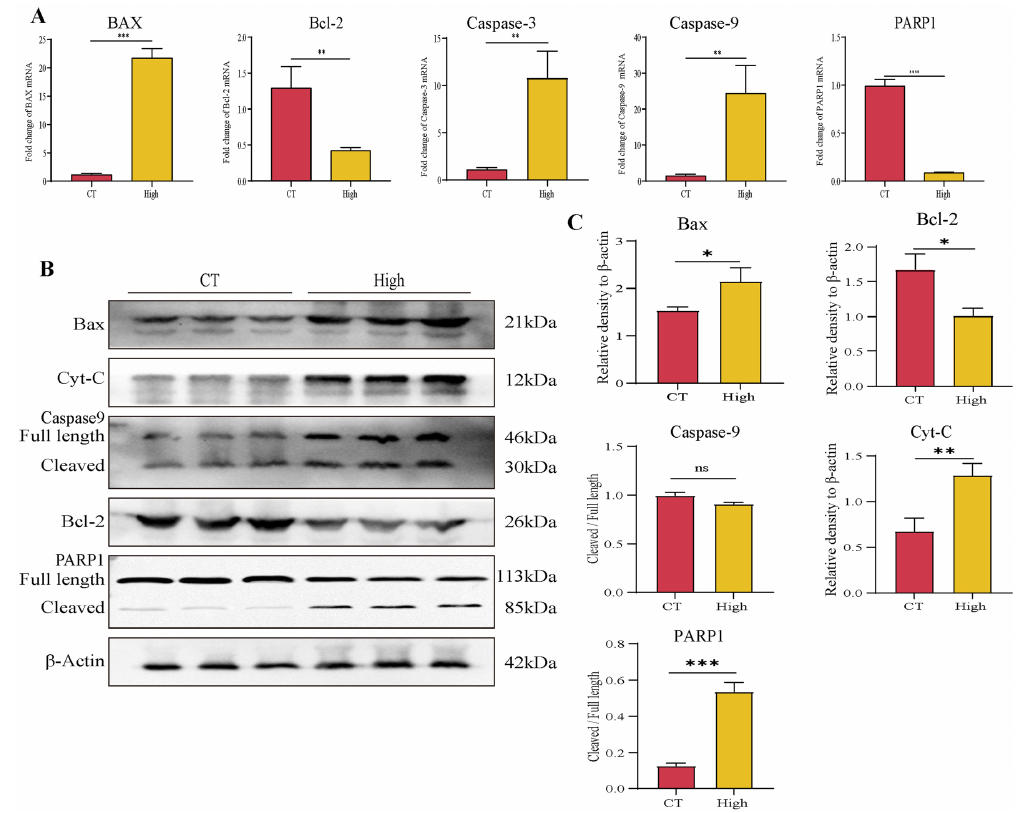
Figure 9. TAX induces apoptosis in vivo: ( A ) The expression of several key apoptosis regulators was detected using RT-qPCR after the treatment of TAX in tumor tissue of tumor-bearing mice. ( B , C ) The expression of several key apoptosis regulators was detected using western blotting after the treatment of TAX in tumor tissue of tumor-bearing mice. Images were quantified and statistically analyzed. ns, not significant, * p < 0.05, ** p < 0.01, *** p < 0.001. (Student’s t -test). Data are presented as mean ± stdv.